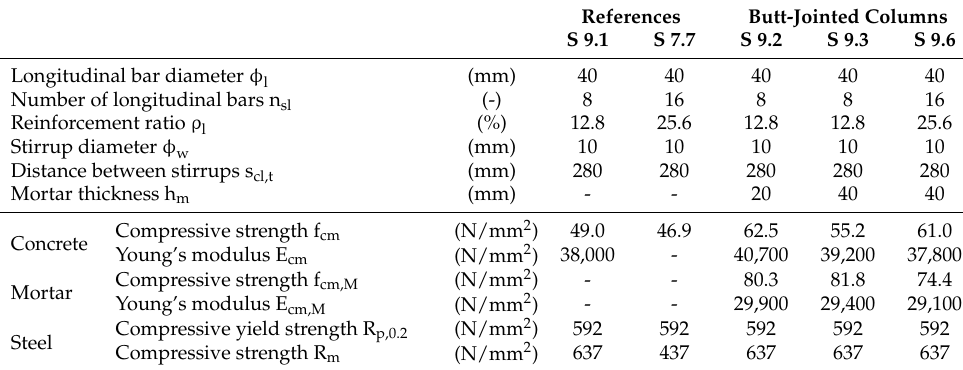
Table 1. Configurations of the test specimens and material properties of concrete, mortar and longitudinal reinforcement.